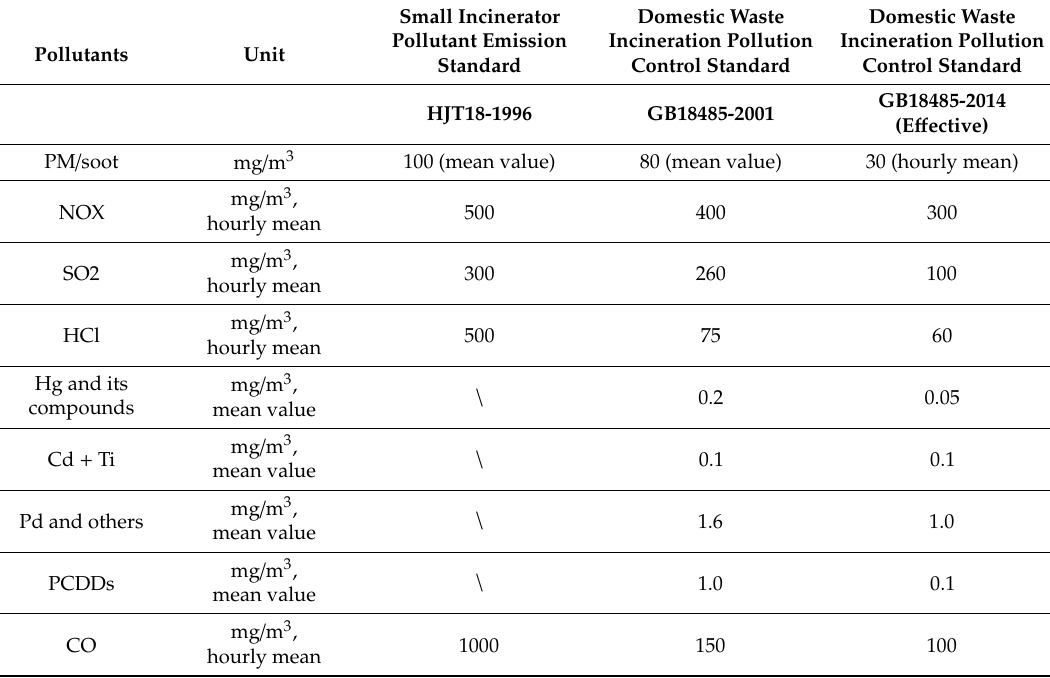
Table 1. Standard pollutants emission limits for di ff erent periods in